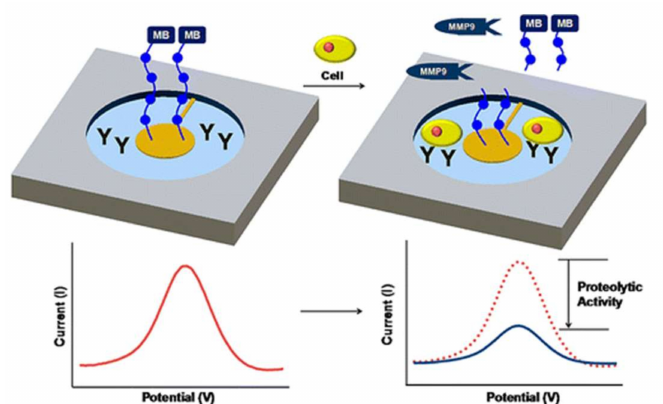
Figure 4. Schematic illustration of matrix metalloproteinase MMP-9 electrochemical biosensors